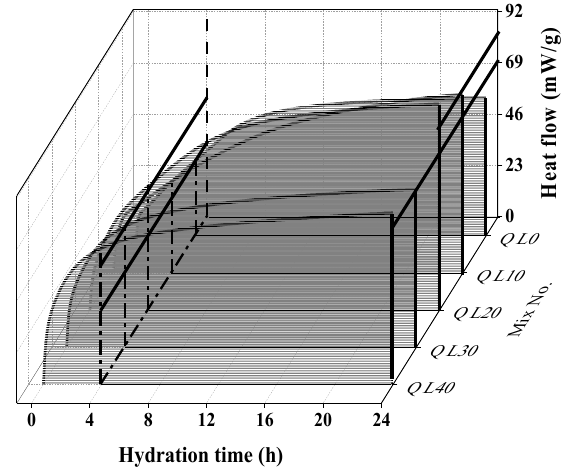
Figure 8. Effect of quicklime on the accumulated hydration heat. Figure 8. E ff ect of quicklime on the accumulated hydration heat.